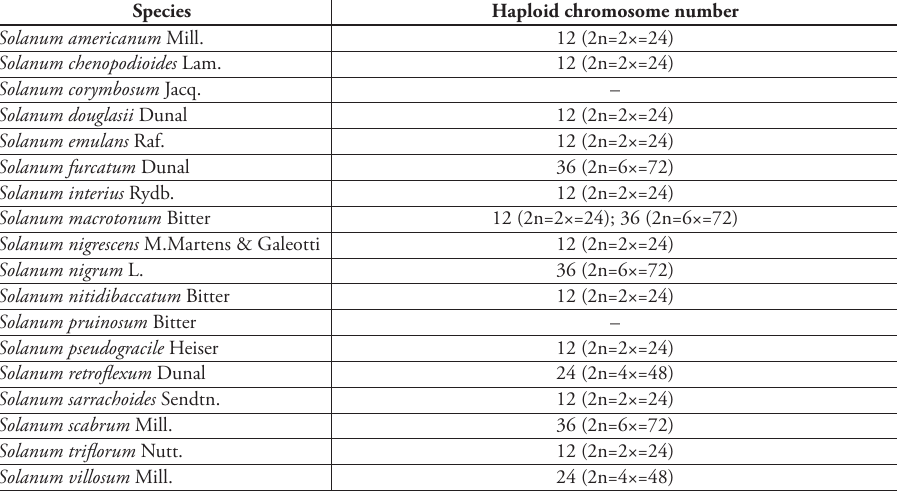
Table 2. Chromosome counts for species of the Morelloid Clade of Solanum . For references see indi- vidual species treatments. Species Haploid chromosome